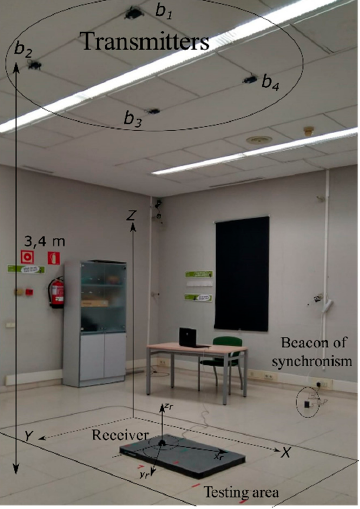
Figure 7. Setup for real experimentation and validation of the proposed system.